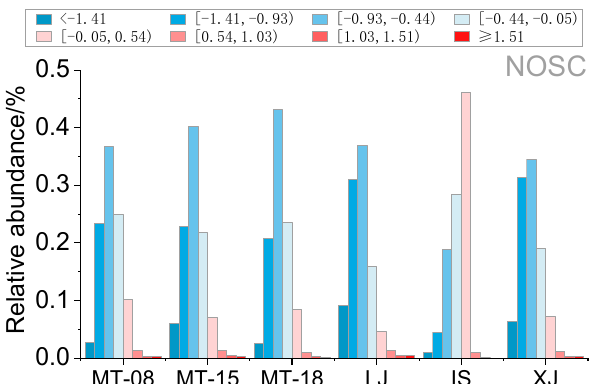
Figure 8. The relative abundance of different NOSC ranges in each sauce-flavor Baijiu sample. The colors represent the different NOSC ranges.